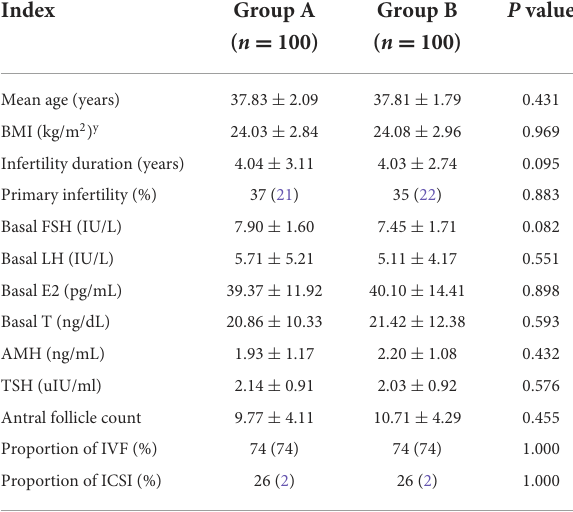
TABLE 1 Baseline characteristics of the study population * . TABLE 2 Therapeutic outcome in the study population *